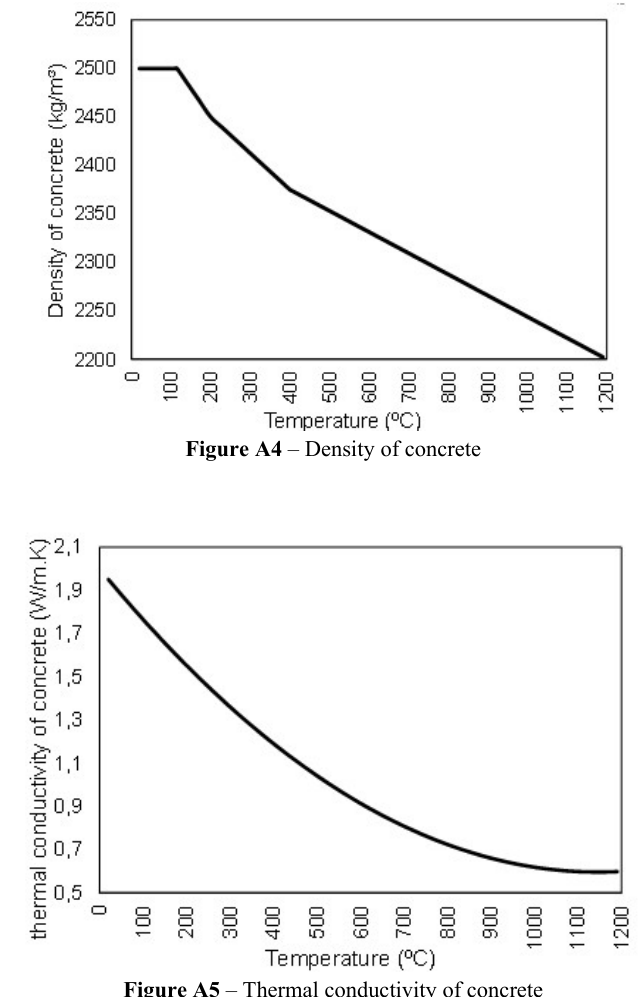
Figure A5 – Thermal conductivity of